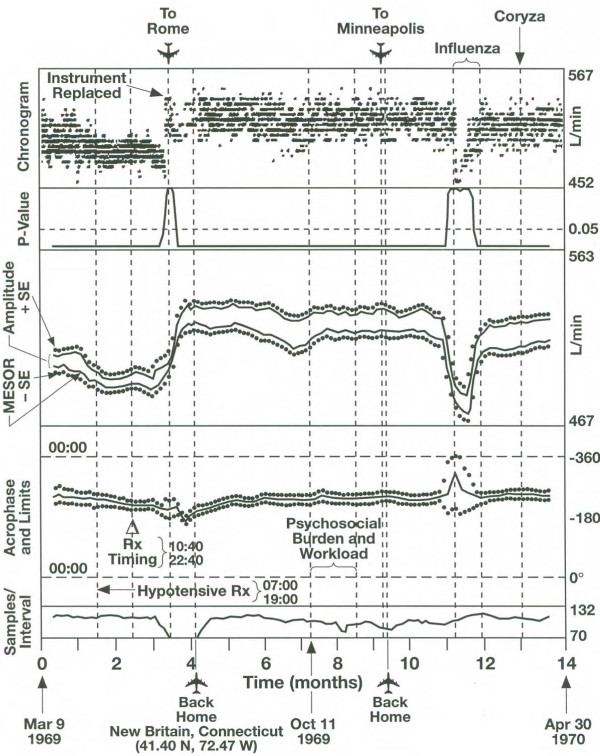
Chronobiologic serial section. Peak expiratory flow was self-measured several times a day by a 53-year old man. The data covering a 14-month span are shown in row 1. They are analyzed in a 20-day interval progressively displaced by 2 days. Data in each interval are fitted with a 24-hour cosine curve. From the P-values shown in row 2, it can be seen that the circadian rhythm was detected with statistical significance most of the time, except for two short spans, one coinciding with a transmeridian flight (when fewer data were collected, row 5) and the other with influenza. Whereas the 24-hour acrophase remains relatively stable throughout the record (row 4), the MESOR (row 3, lower curve) and to a lesser extent the circadian amplitude (row 3, distance between the two curves) undergo sharp changes, notably in association with the influenza and earlier with a change in treatment timing. © Halberg Chronobiology Center.